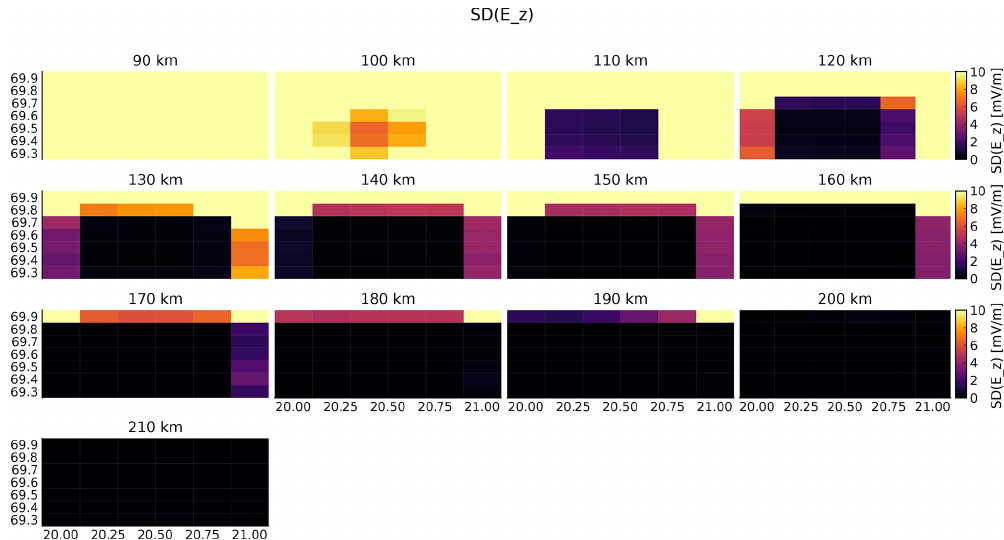
Figure 8. Uncertainty in electric field in field-aligned direction.